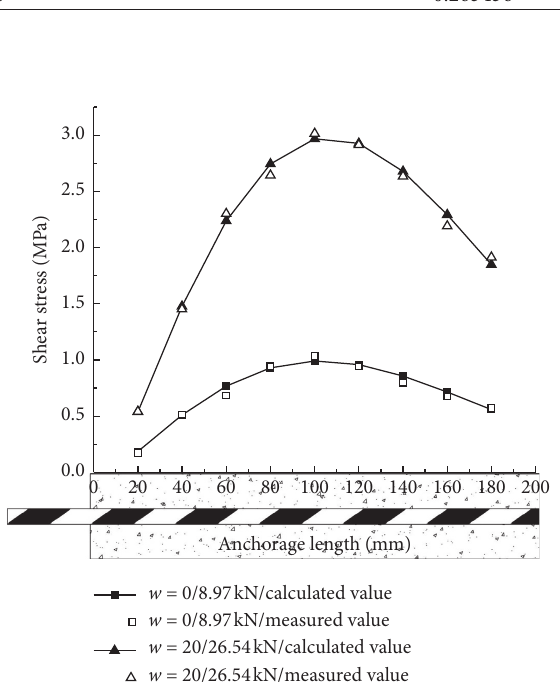
Figure 21: Comparison of measured and calculated shear stress.